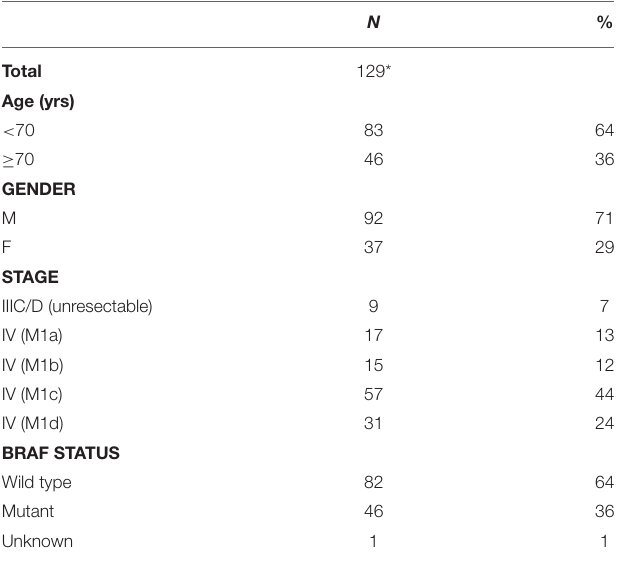
TABLE 1 | Patient